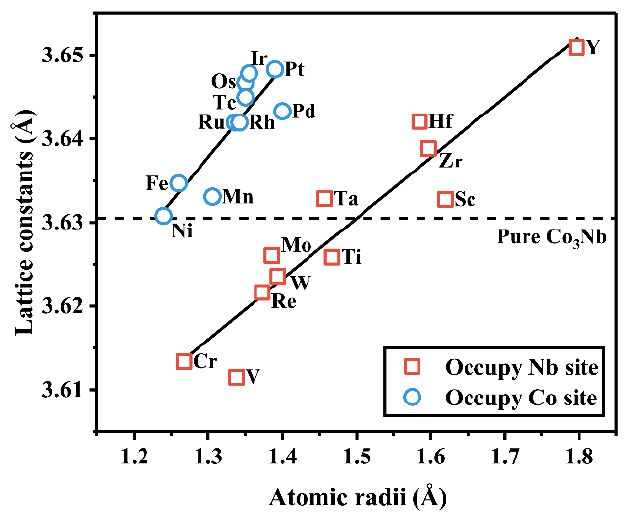
Figure 3. Relationship between the lattice parameters of X-substituted γ′ -Co 3 Nb and the atomic radius of X.